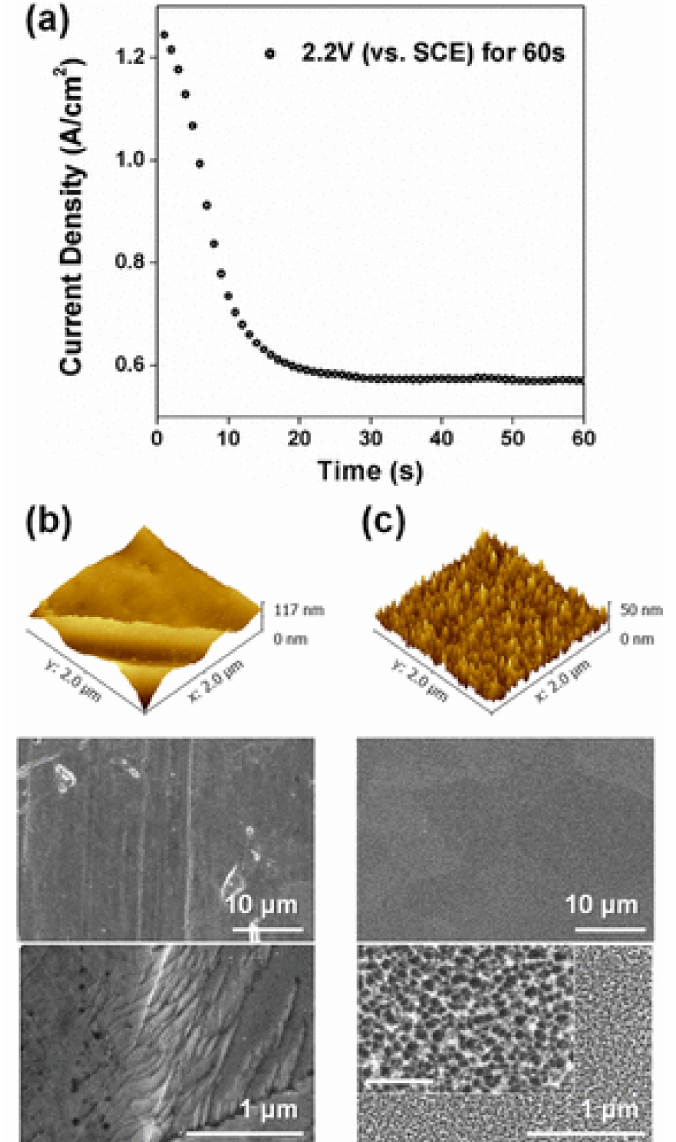
Figure 11. Structure characterization of stainless steel 316L surfaces after electrochemical modification: ( a ) potentiostatic polarization at an anodic potential of 2.2 V (vs. a saturated calomel electrode (SCE)) for fabricating a nanotextured SS316L (Nanotexturized-SS316L) surface. Three-dimensional AFM topography profiles and SEM images of: ( b ) as received (AR-SS316L); and ( c ) nanotextured (NT- SS316L) surfaces. The scale bar of the inset SEM image is 200 nm. Figure derived from the work